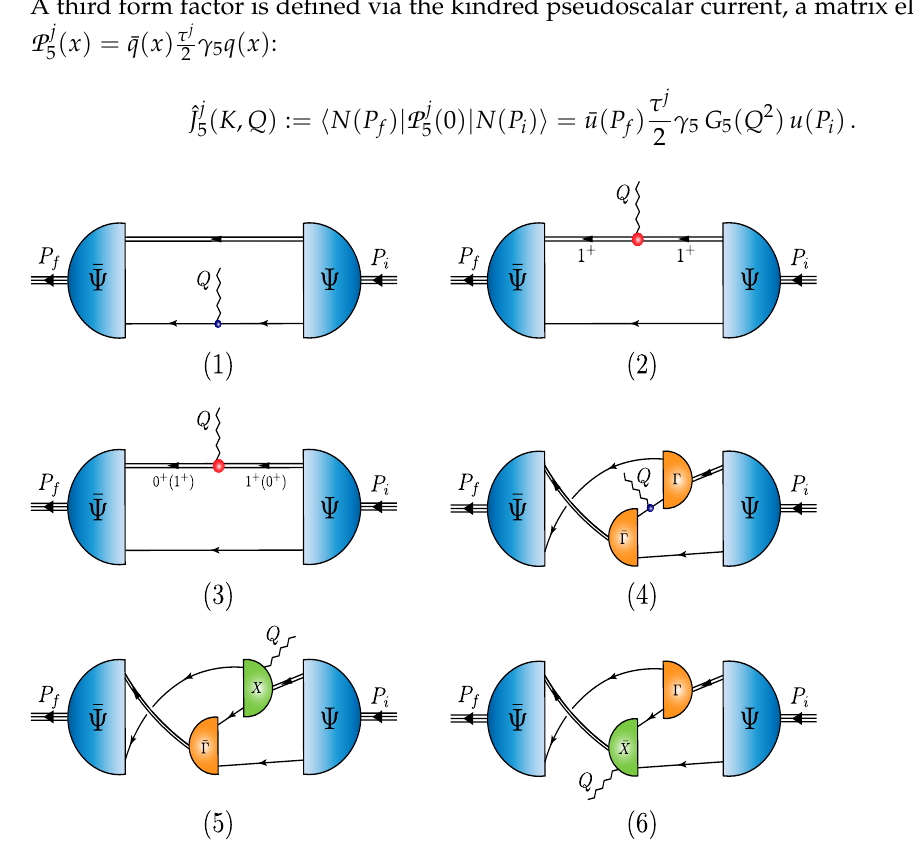
Figure 14. Axial/pseudoscalar current that ensures a symmetry-preserving interaction with an on- shell baryon described by a Faddeev amplitude obtained from the equation depicted in Figure 8: single line , dressed quark propagator; undulating line , axial/pseudoscalar current; Γ , diquark correlation amplitude; double line , diquark propagator; χ , seagull terms. A detailed legend is provided in Table